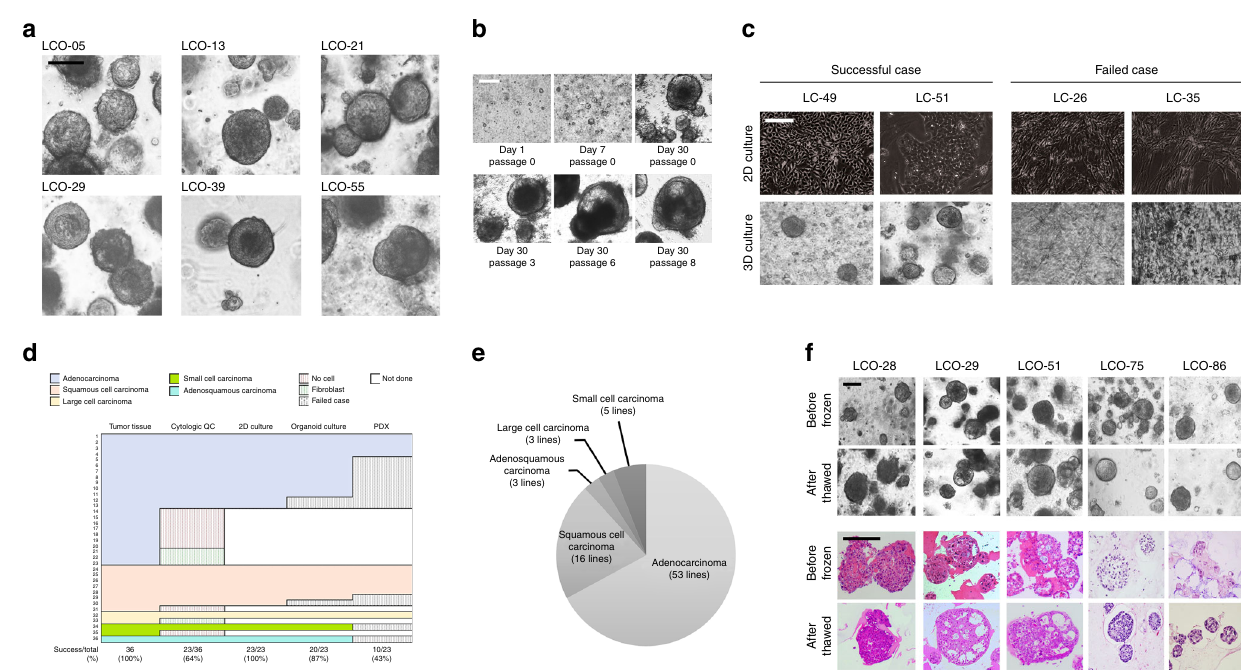
Fig. 1 LCOs established for the lung cancer biobank. a Bright- fi eld microscopy images of LCOs cultured for 2 weeks. Scale bar, 100 μ m. The information of LCOs in these images; LCO-05, LCO-36, and LCO-55; adenocarcinoma, LCO-13; squamous cell carcinoma, LCO-21; small cell carcinoma, LCO-29; large cell carcinoma. b Representative images of long-term cultured LCOs. This LCO was derived from LC-49. Scale bar, 200 μ m. c Representative images of successful and failed 2D and 3D cultures derived from lung cancers with different tissue composition. Scale bar, 200 μ m. d The graph showing the successful or failed cases according to cancer tissue quality and the establishment rate of each cancer models according to lung cancer subtypes. Cytologic QC, cytologic quality check. e Pie chart showing the subtypes of established 80 LCOs for the lung cancer biobank. The information of 80 LCOs is shown in Table 2. f Bright- fi eld microscopy images and H&E staining images of LCOs before freezing and after thawing. Scale bar, 200 μ m. The information of LCOs in these images: LCO-28 — squamous cell carcinoma; LCO-29 — large cell carcinoma; LCO-51 — adenocarcinoma; LCO-75 — small cell carcinoma; LCO- 86 — adenosquamous